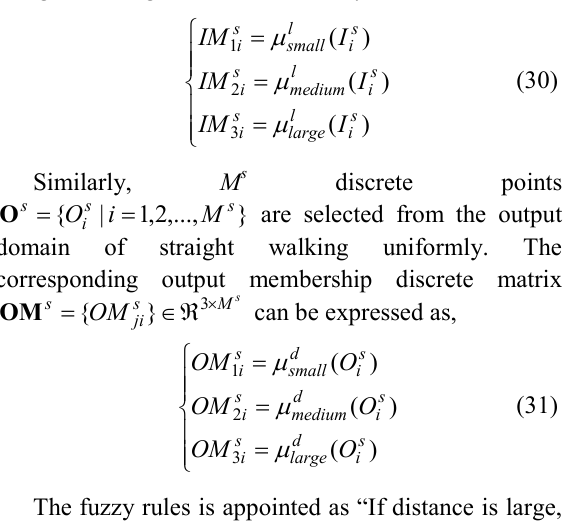
Fig. 7. Diagram of Membership function of straight walking. (a) Distance/input membership function. (b) Step length/output membership